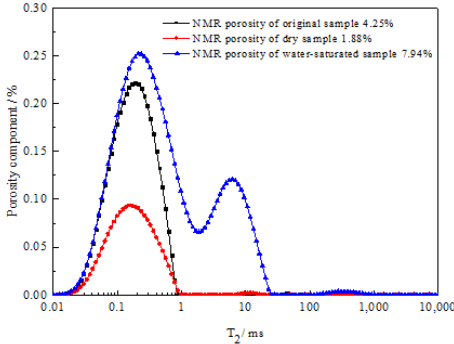
Figure 4. Liquid logging porosity vs. NMR porosityore samples of shale.